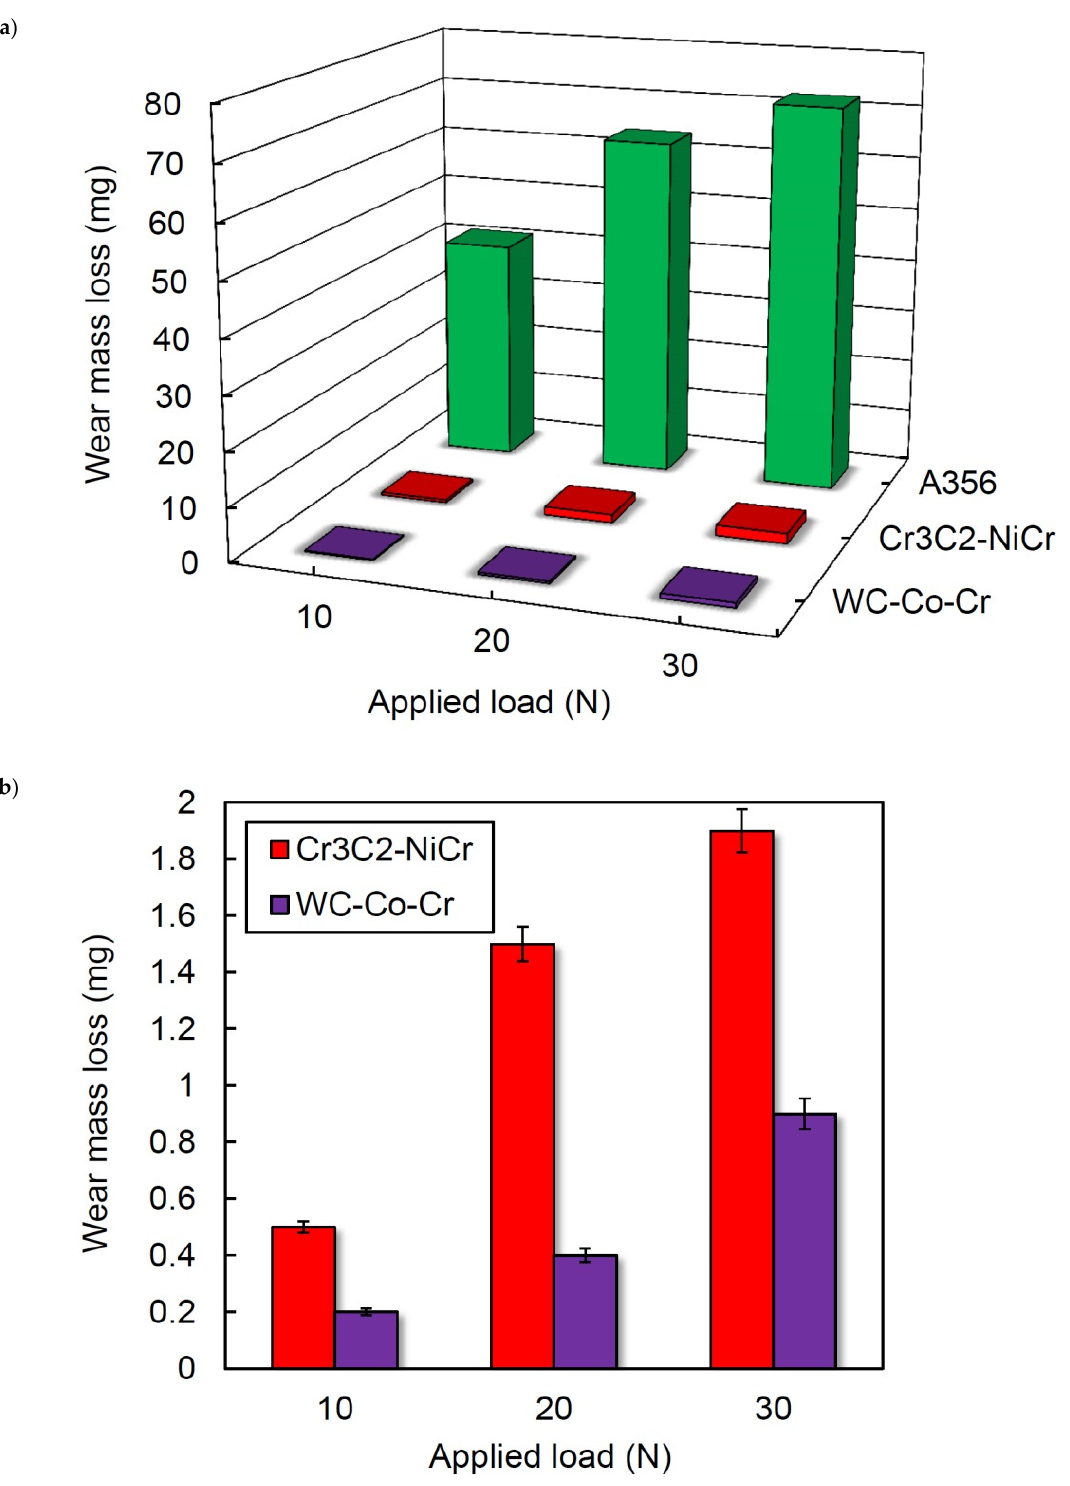
Figure 6. ( a ) Variations of mass losses after 200 m sliding distance as a function of applied load for A356 substrate and coatings; ( b ) closer comparison of Cr 3 C 2 -NiCr and WC-Co-Cr coatings.